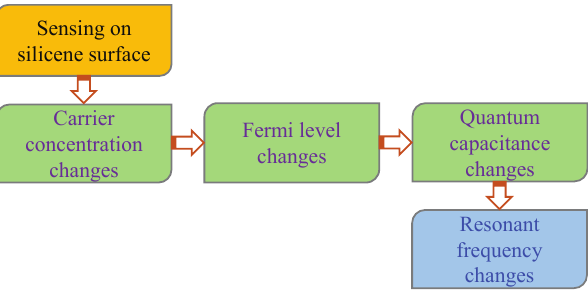
Figure 2. Transduction method of silicene quantum capacitance-based frequency readout.